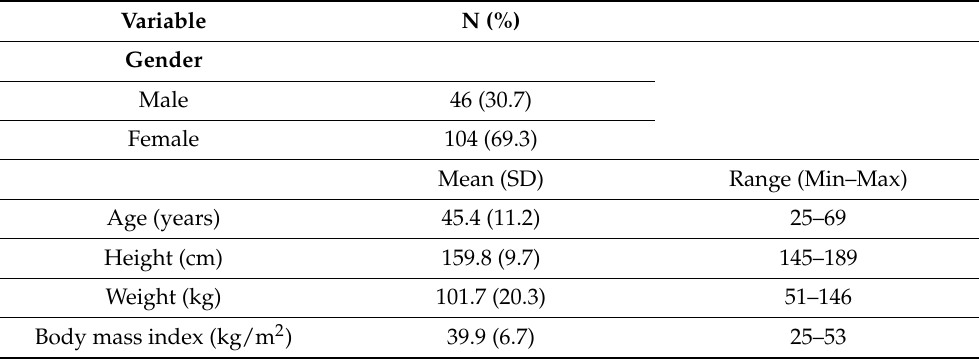
Table 2. Baseline characteristics.